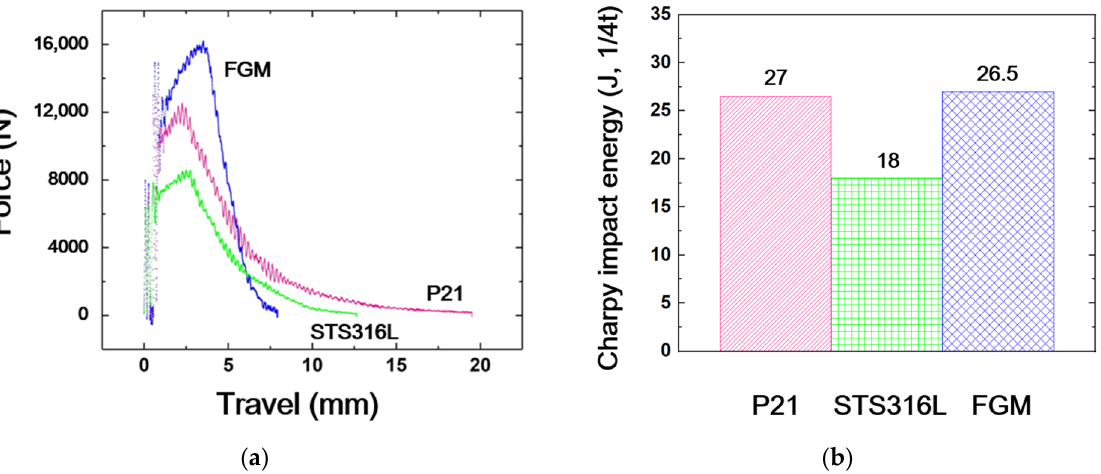
Figure 18. Instrumented Charpy impact tests results of 2.5 mm sub-size specimens of P21, STS316L and FGM: ( a ) force–travel curve; ( b ) Charpy impact energy.